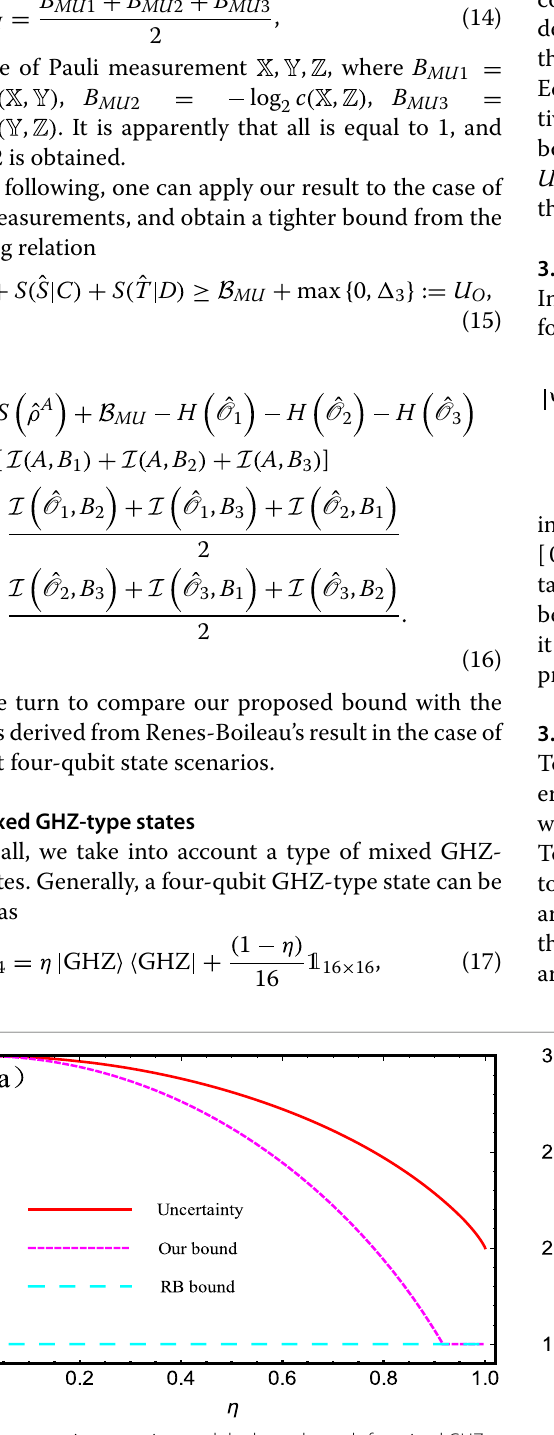
Fig. 1 The entropic uncertainty and the lower bounds for mixed GHZ-type states. a Uncertainty and the lower bounds vs the state’s purity . Red solid line denotes the quantity of the entropy-based uncertainty (left-hand side of Eq. (13)), magenta dashed line denotes our result (right-hand side of Eq. (15)) and cyan dashed line denotes Renes-Boileau’s result for four-qubit (right-hand side of Eq. (13)). b Uncertainty and the lower bounds vs the state’s parameter . Red solid line denotes the quantity of the entropy-based uncertainty (left-hand side of Eq. (13)), magenta dashed line denotes our result (right-hand side of Eq. (15)) and cyan dashed line denotes Renes-Boileau’s result for four-qubit (right-hand side of Eq.